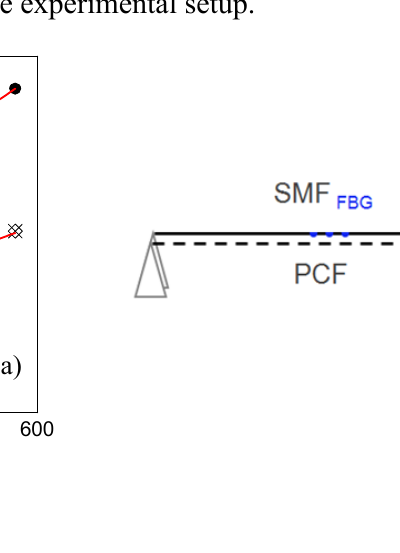
Figure 4. ( a ) Response of the HiBi PCF fiber modal interferometer and FBG to longitudinal strain; ( b ) Schematic of the experimental